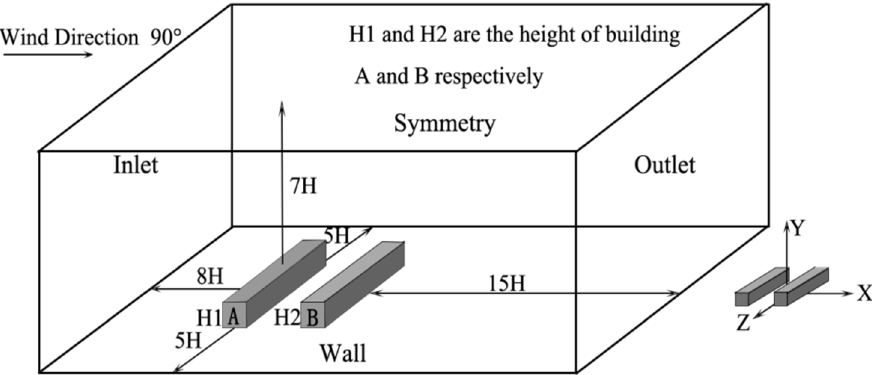
Figure 6. Boundary